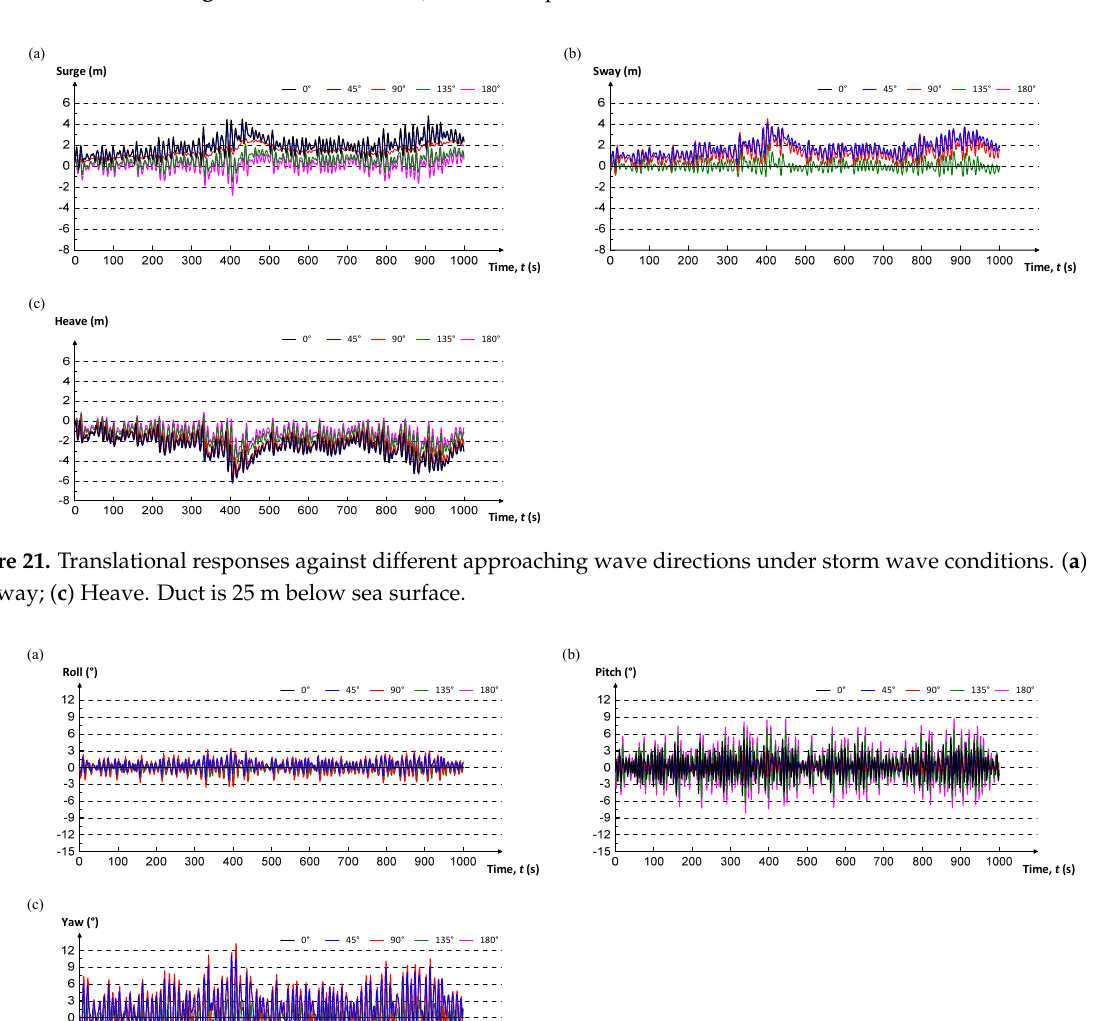
Figure 20. Waveform of JONSWAP spectrum under storm wave condition.